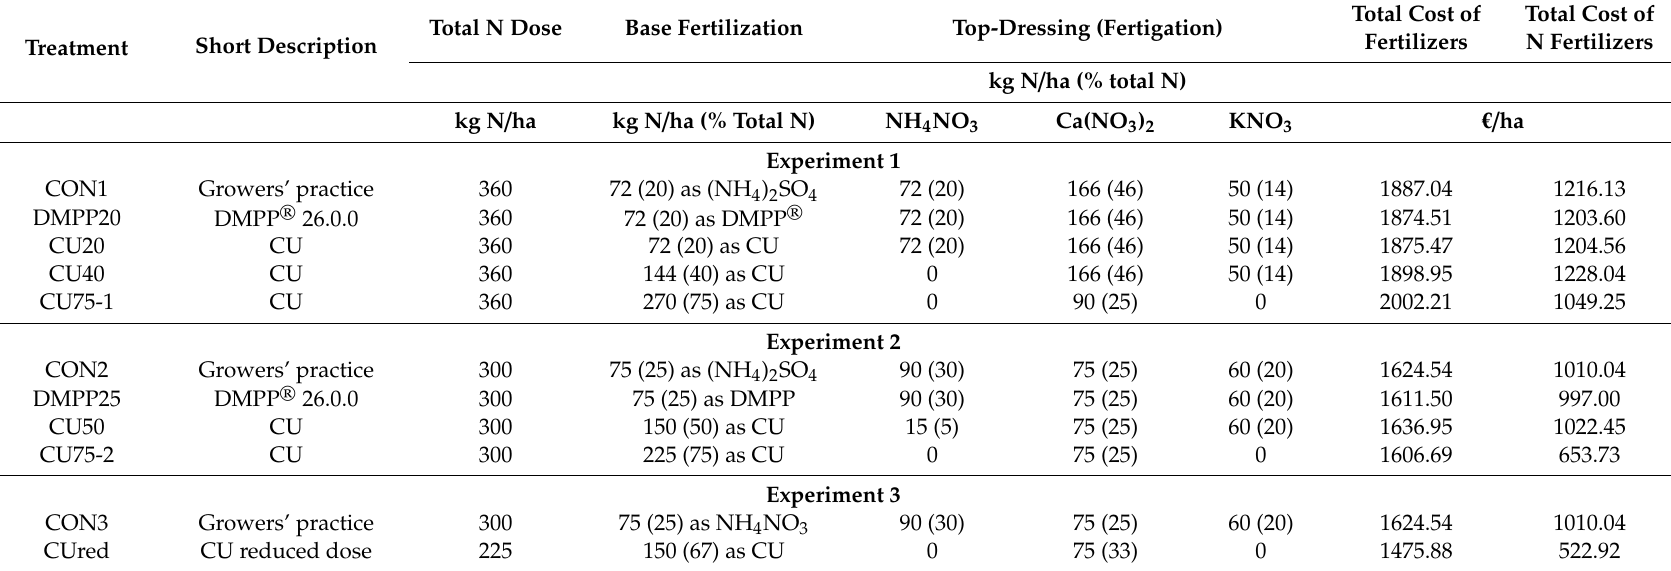
Table 1. Description of the fertilization treatments applied in the three experiments and total cost of fertilizers.